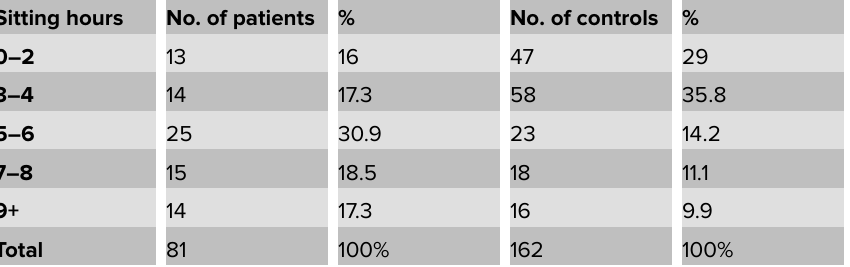
Table 2: Distribution of cases and controls according to sitting hour categories.